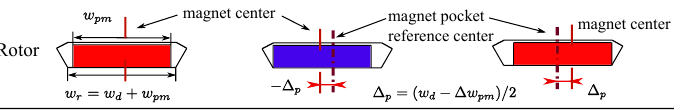
Figure 11. The uncertainties of PM assembling